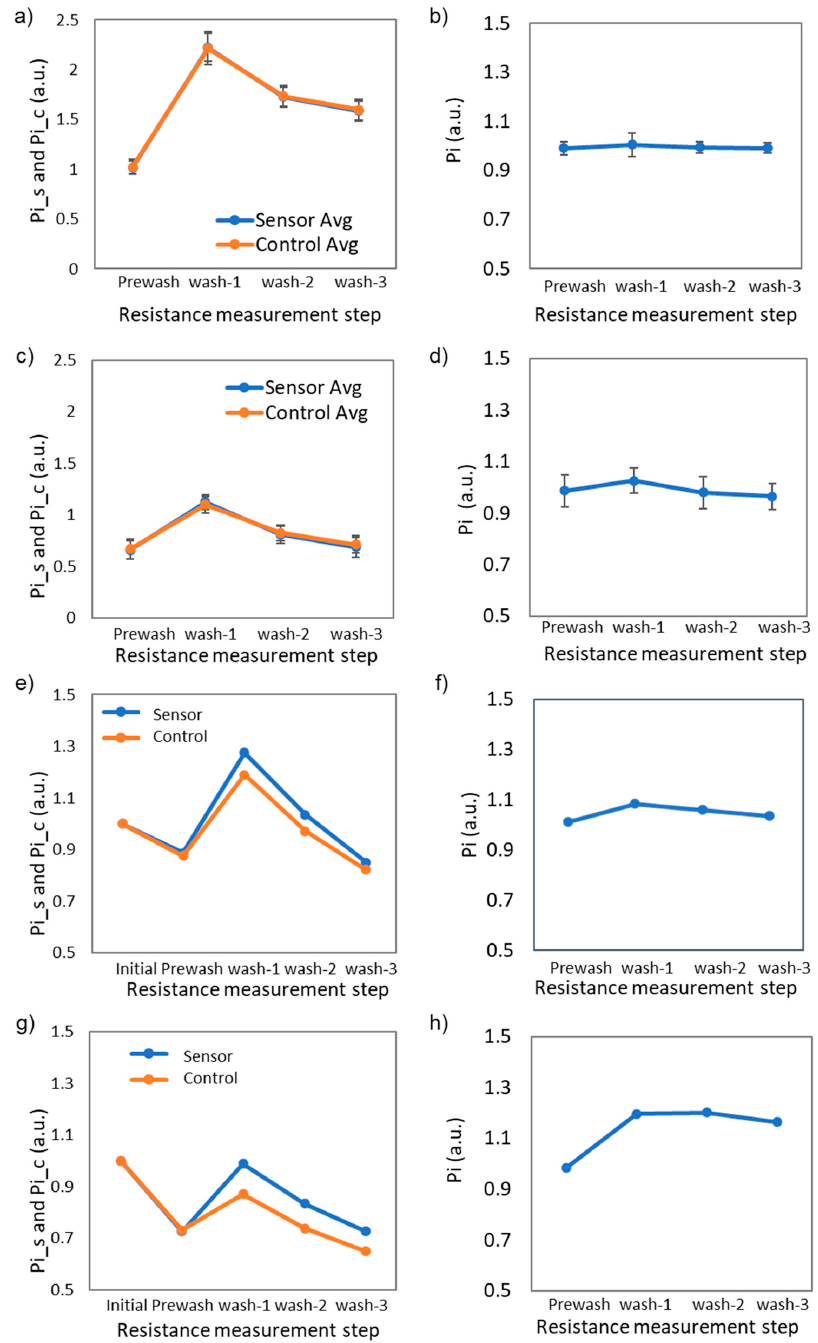
Figure 4. ( a ) P i_s and P i_c changes for the sensors without antibodies (N=6). ( b ) P i changes for the sensors without antibodies (N=6). ( c ) P i_s and P i_c changes for the sensors with antibodies (N=6). ( d ) P i changes for the sensors with antibodies (N=6). ( e ) P i_s and P i_c changes for the antibody- immobilized sensors for a negative nasal swab sample. ( f ) P i changes for the antibody-immobilized sensors for a negative nasal swab sample. ( g ) P i_s and P i_c changes for the antibody-immobilized sensors for a negative nasal swab sample spiked with SARS-CoV-2 (10 3 genome equivalents/mL). ( h ) P i changes for the antibody-immobilized sensors for a negative nasal swab sample spiked with SARS-CoV-2 (10 3 genome equivalents/mL). Table 2 shows one example of the measured resistance values for sensing and control electrodes. The resistance values were converted to the resistance ratio in Figure 4c.